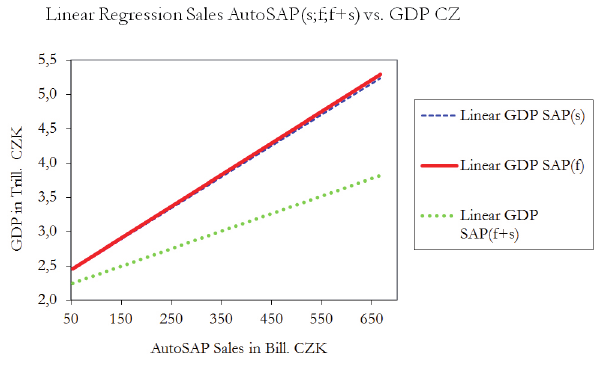
Fig. 5 – Linear Regression Lines AutoSAP RI Sales vs. CZ GDP. Source: own